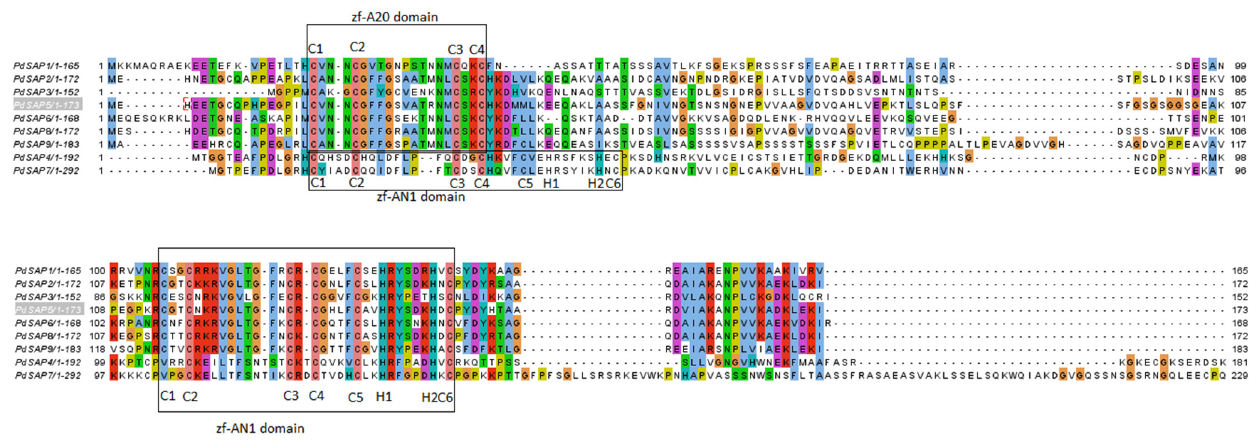
Figure 1. Multiple sequence alignment of SAP gene sequences. Multiple sequence alignment of zf-A20/AN1 domains using Jalview. Conserved zf-A20 and zf-AN1 domains are boxed.